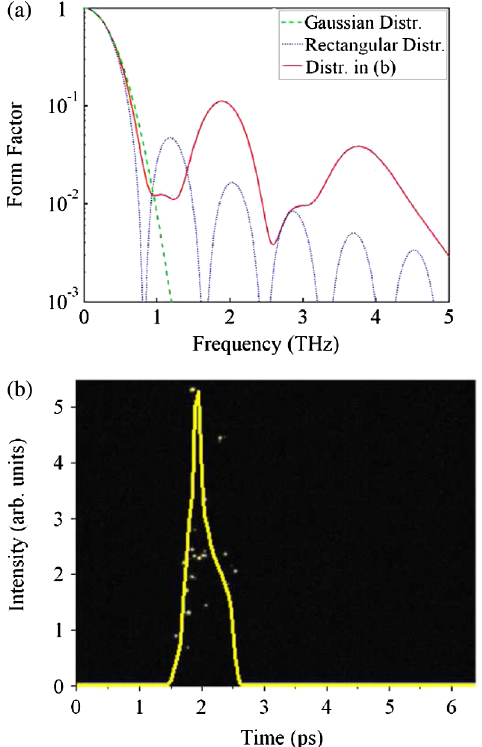
FIG. 6. (a) Bunch form factors for the Gaussian distribution, the rectangular distribution, and the bunch distribution in (b), and (b) streak camera image (bright points) and longitudinal bunch distribution (solid line) obtained from that.